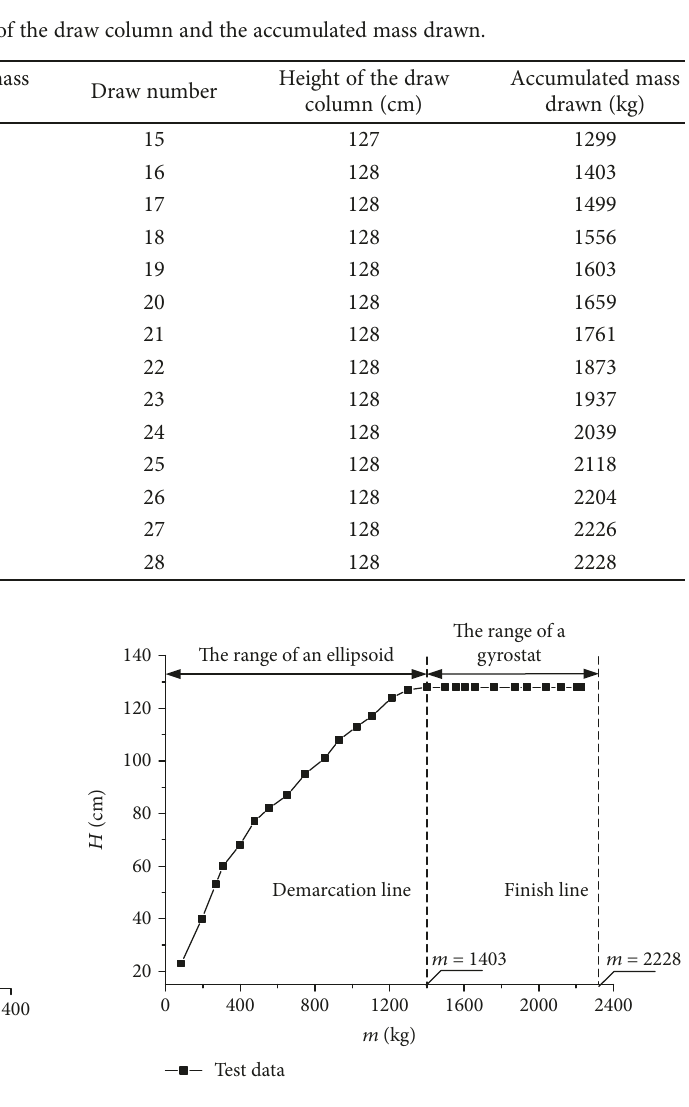
Figure 9: Relationship between the height of the draw column and the accumulated mass drawn in the numerical test.